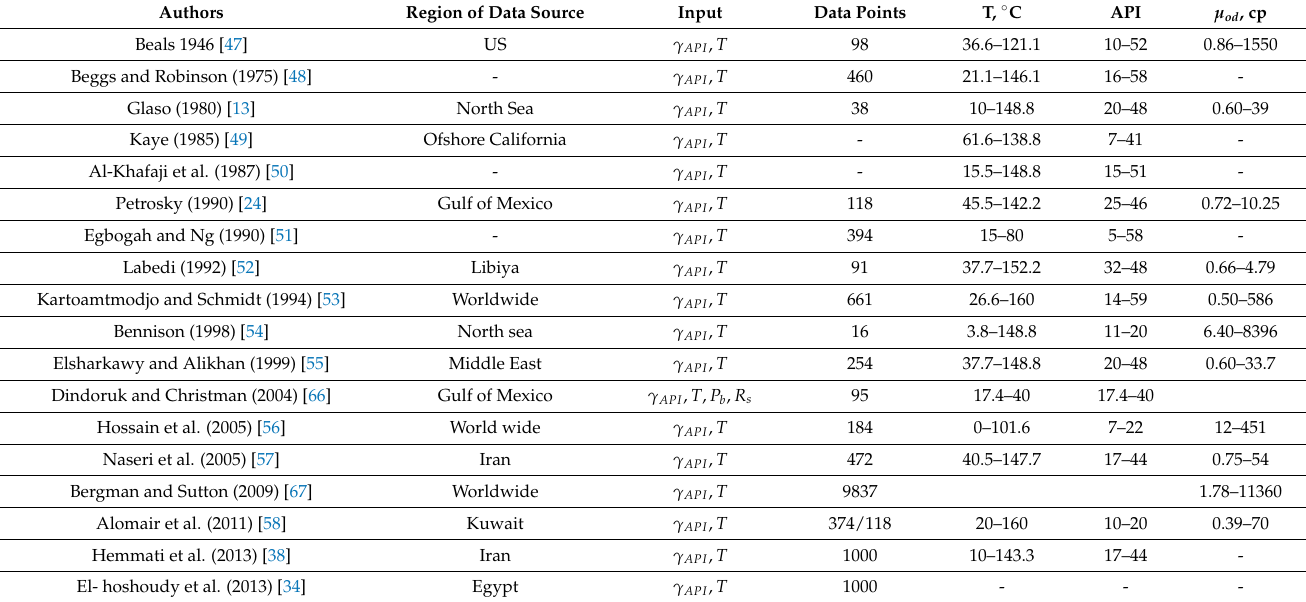
Table 1. The summary of the ranges and origins data used in some famous dead oil viscosity